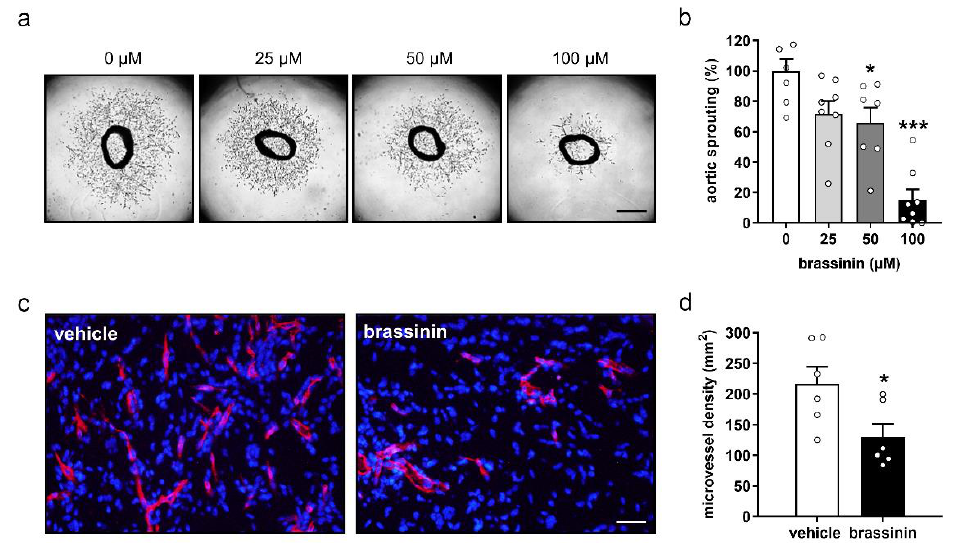
Figure 2. Brassinin inhibits angiogenesis in ex-vivo and in-vivo assays. ( a ) Images of mouse aortic rings that were treated for 6 days with 0, 25, 50, and 100 µM brassinin. Scale bars: 630 µm. ( b ) Sprouting (% of 0 µM) of treated mouse aortic rings shown in ( a ) was quantified ( n = 7 – 8). ( c ) Immunohistochemical detection of microvessels (red) in Matrigel plugs containing 100 µM brassinin or DMSO (0.1% v / v ; vehicle). Cell nuclei were stained with Hoechst 33342 (blue). Scale bar: 45 μm. ( d ) Microvessel density (mm −2 ) in Matrigel plugs shown in ( c ) was assessed ( n = 6). Means ± SEM. * p < 0.05, *** p < 0.001 vs. 0 µM or vehicle.